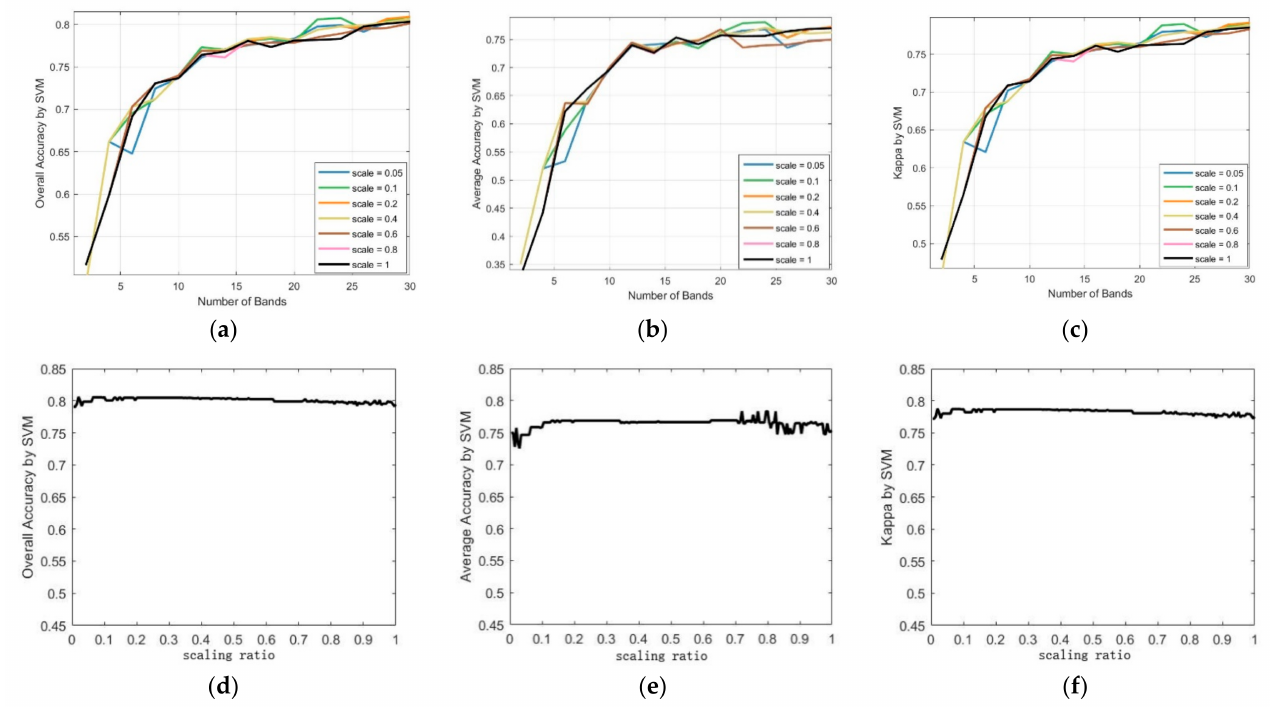
Figure 14. Comparison of classification accuracy with different scaling ratios. ( a – c ) are OA, AA and Kappa Results by SVM. ( d – f ) are OA, AA and Kappa Results under different scaling